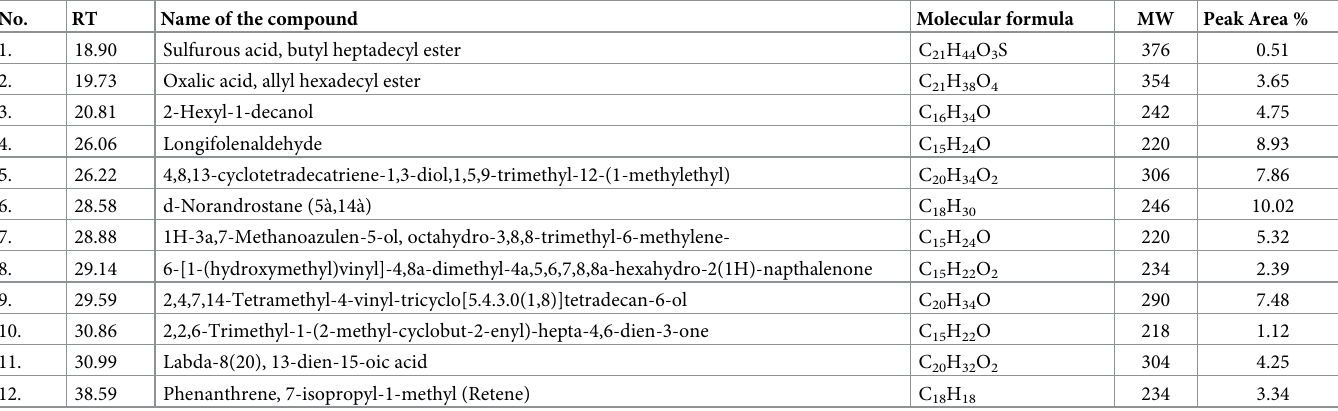
Table 3. Compounds identified from band-C of EA fraction of AE1 by GC-MS analysis.